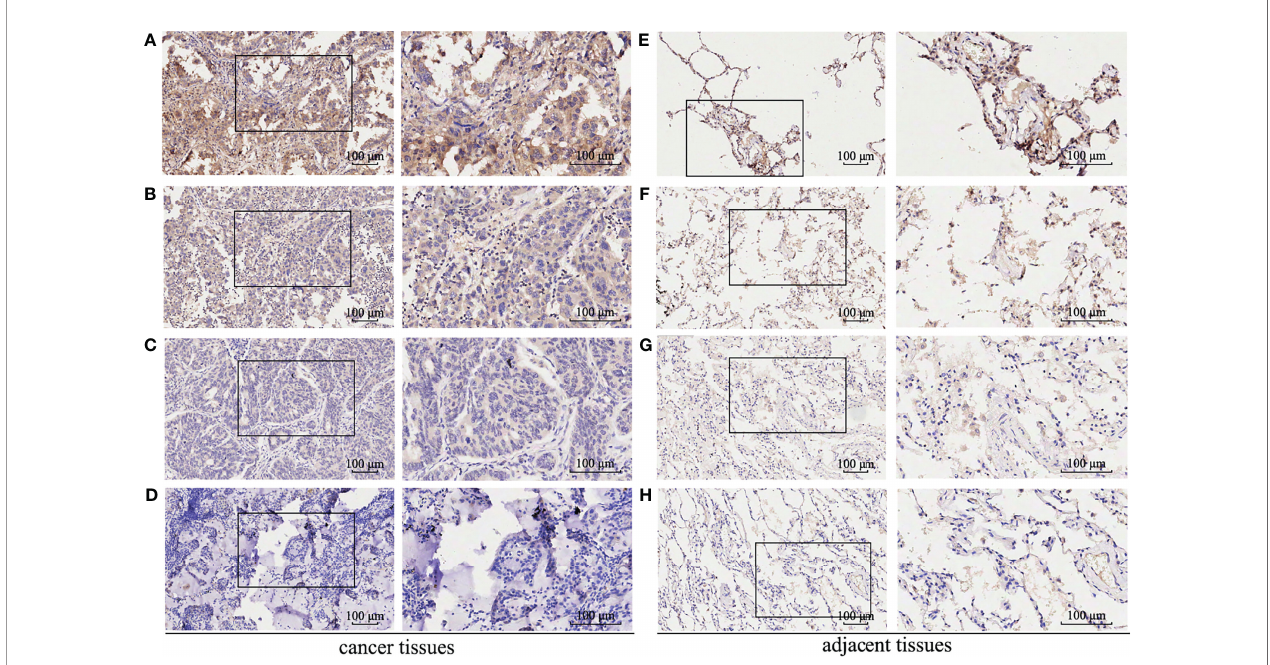
FIGURE 1 | The immunohistochemistry staining of GBE1 in LUAD tissue samples and corresponding noncancer tissue samples. GBE1 protein levels were upregulated in most LUAD tissues compared with the corresponding noncancer tissues in the TMA ‐ IHC results. The representative TMA ‐ IHC images of different staining intensities of GBE1 were as follows (A – H) . (A) Strong intensity of GBE1 in LUAD tissue. (B) Moderate intensity of GBE1 in LUAD tissue. (C) Weak intensity of GBE1 in LUAD tissue. (D) Negative intensity of GBE1 in LUAD tissue. (E) Strong intensity of GBE1 in corresponding noncancer tissue. (F) Moderate intensity of